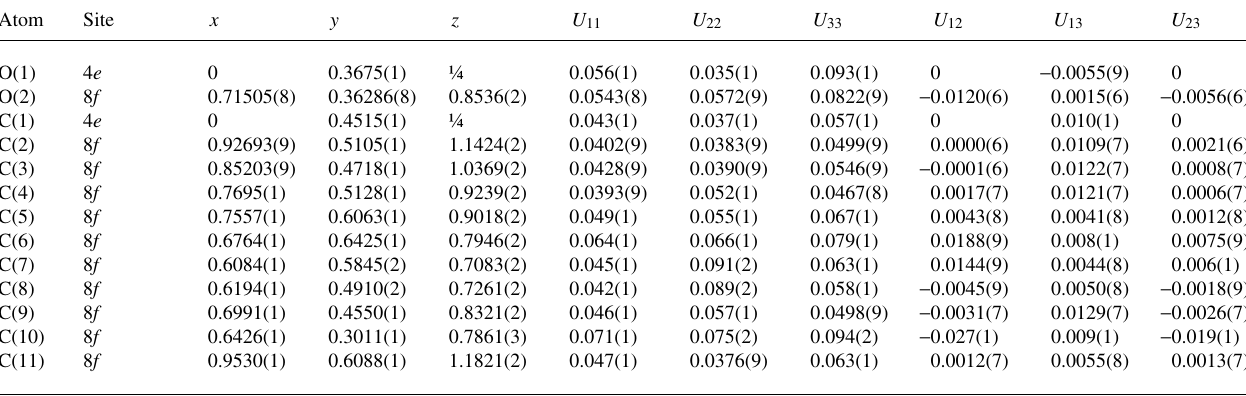
Table 3. Atomic coordinates and displacement parameters (in Å 2 )